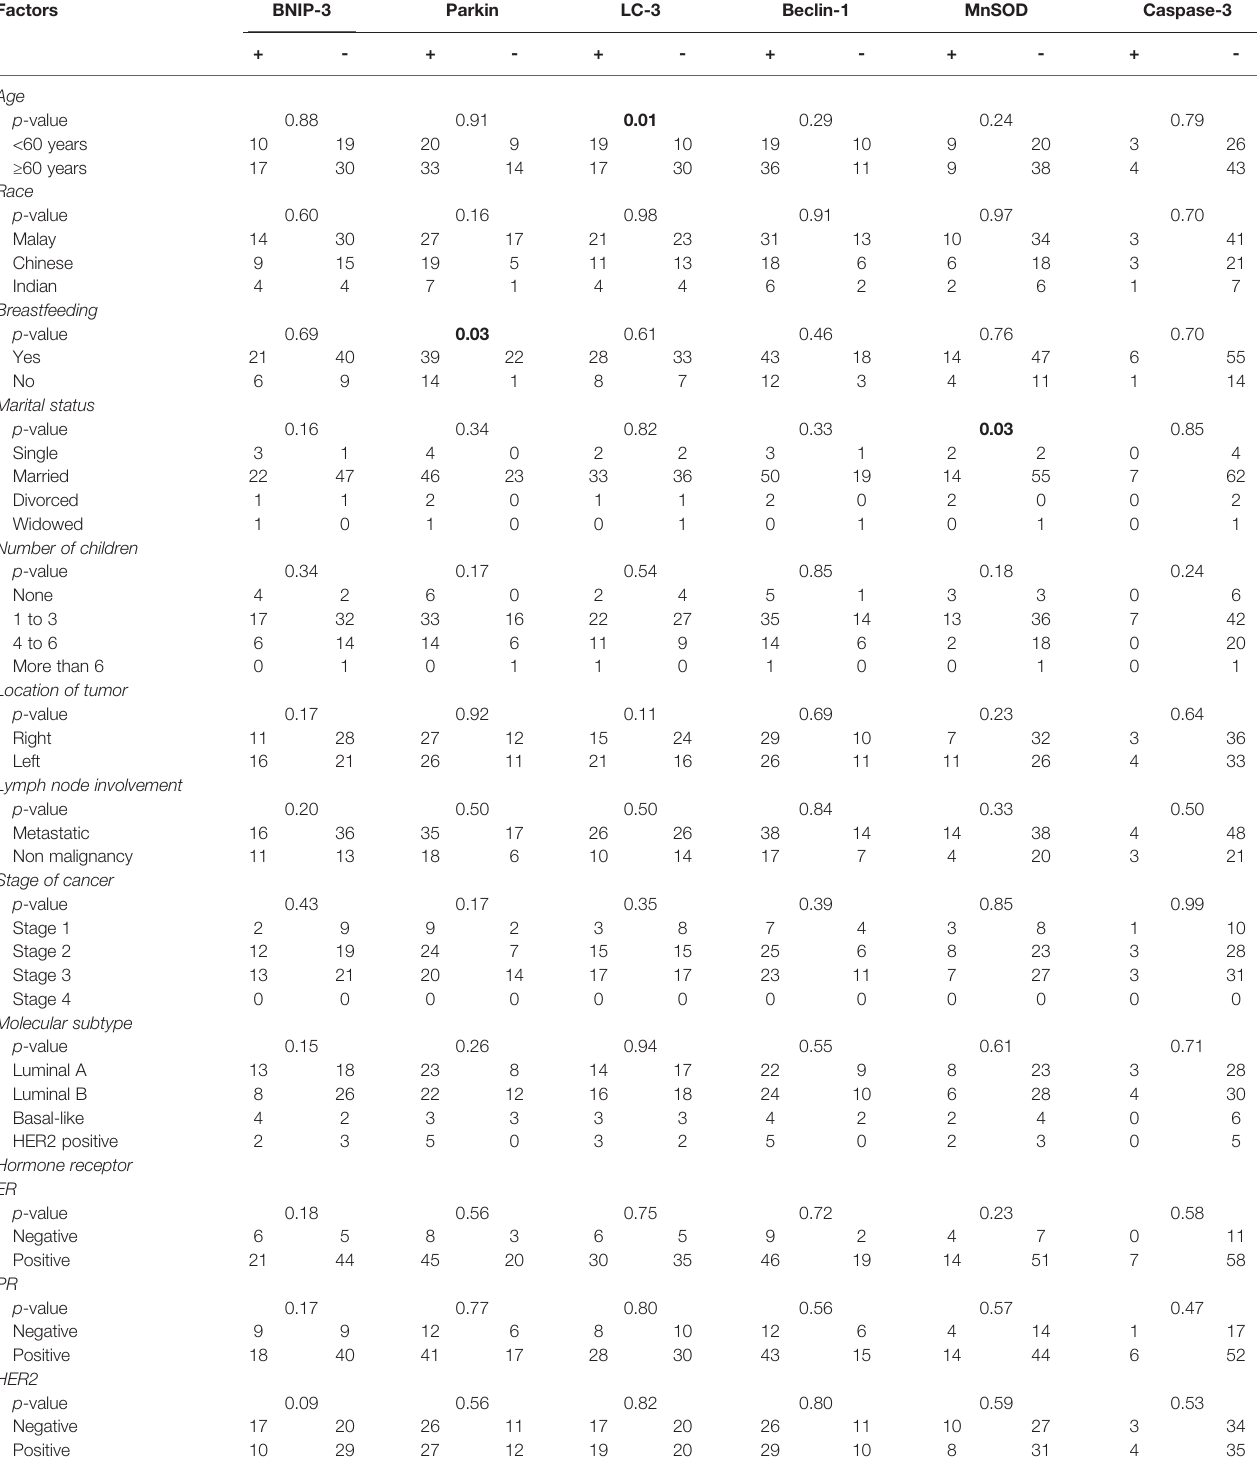
TABLE 2 | Correlation analysis of MnSOD, Caspase-3, Beclin-1, LC-3, BNIP-3, and Parkin expression and clinicopathological factors.